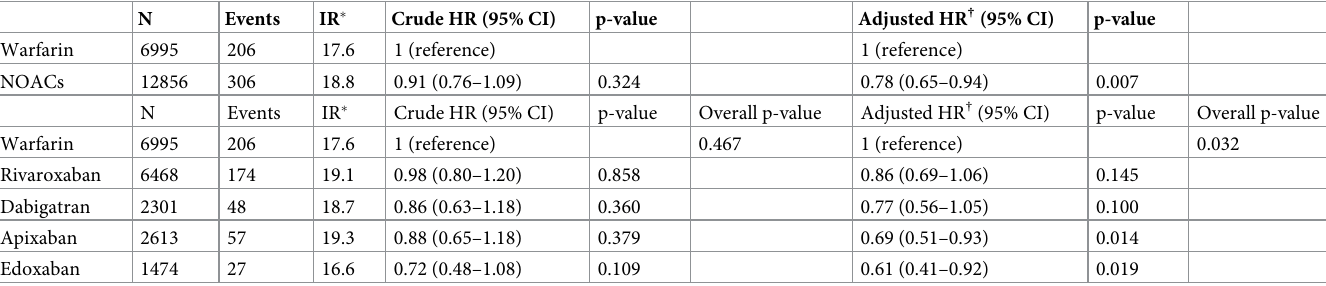
Table 2. Upper gastrointestinal bleeding risk according to OAC